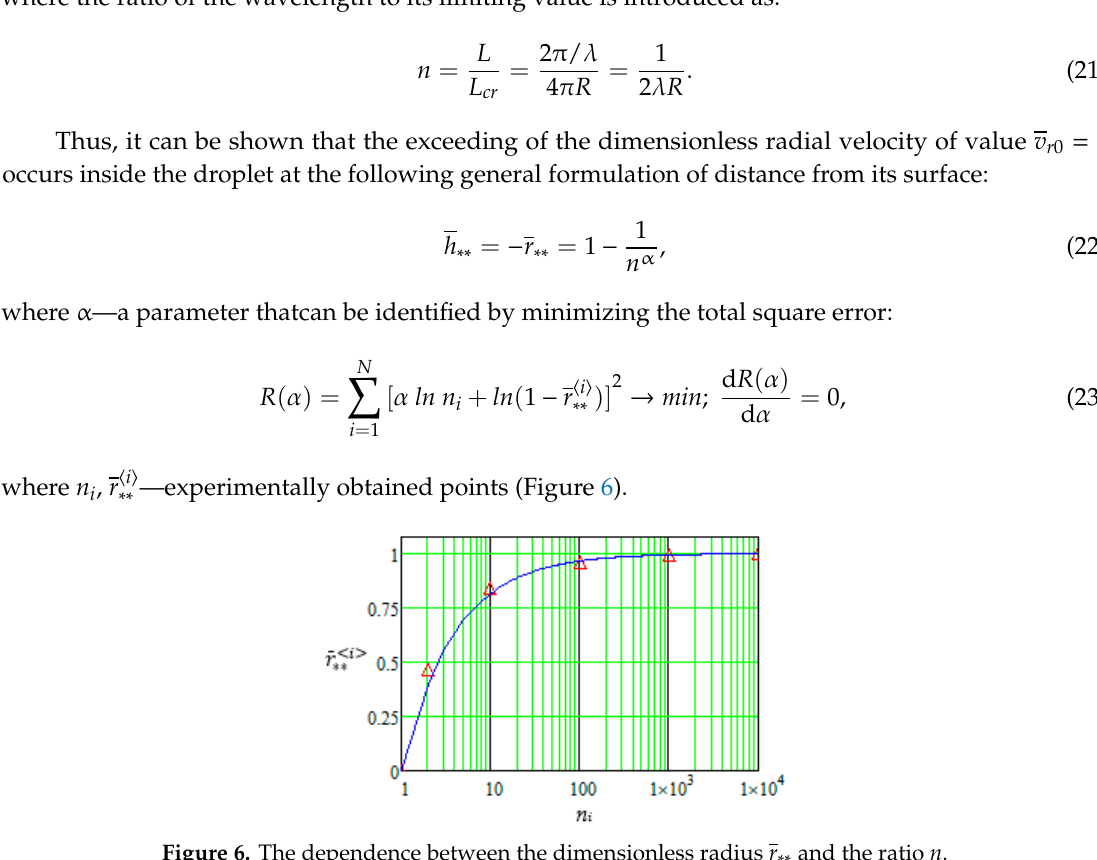
Figure 6. The dependence between the dimensionless radius r ∗∗ and the ratio n